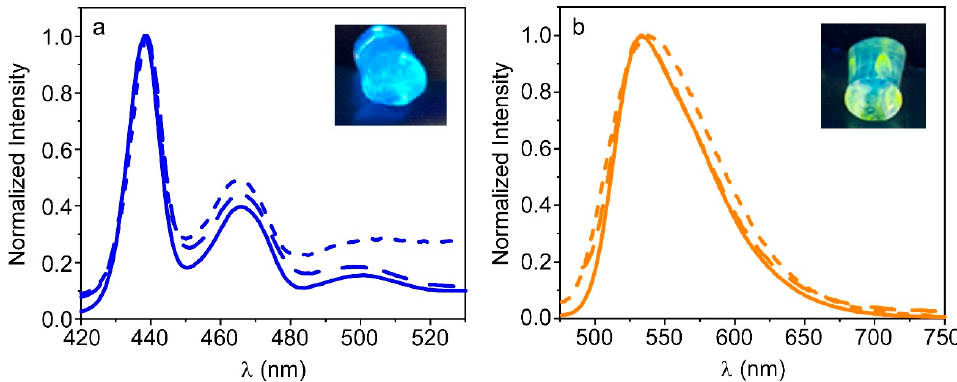
Figure 4. Normalized fluorescence emission spectra of PFO ( a ) and F8BT ( b ) CNPs in a solution of TRIS buffer (solid line), immobilized in hydrogels in situ (dotted line) and ex situ (dashed line). Insets: Digital image of PFO@AETA ( a ) and F8BT@AETA ( b ) hydrogels taken under irradiation with UV light (365 nm).